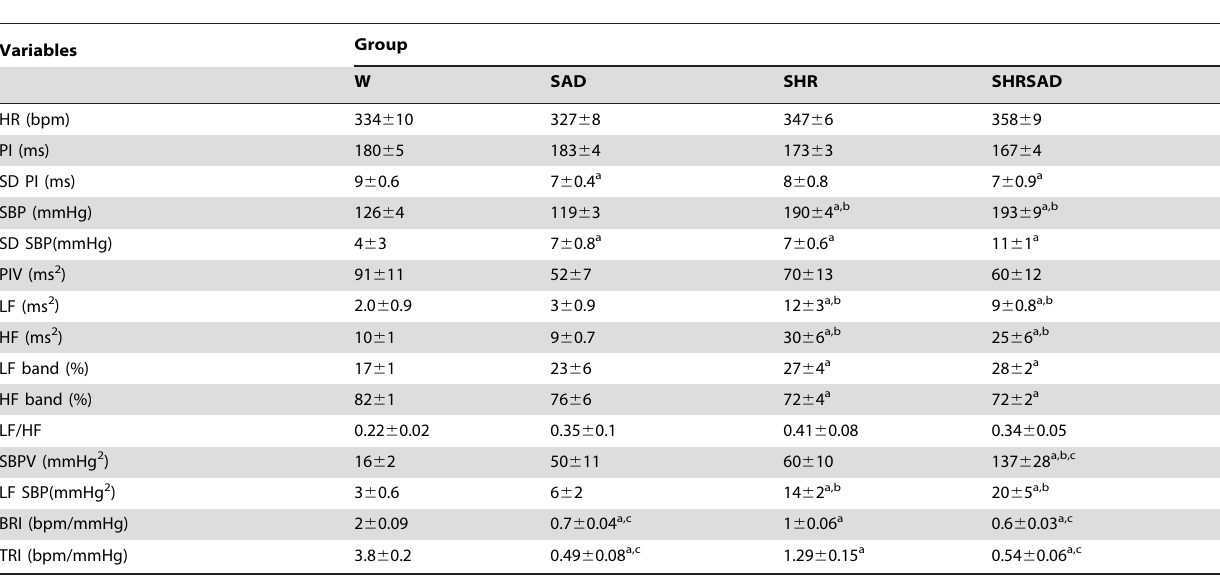
Table 1. Blood pressure, heart rate, baroreflex sensitivity and cardiovascular autonomic modulation of normotensive and hypertensive